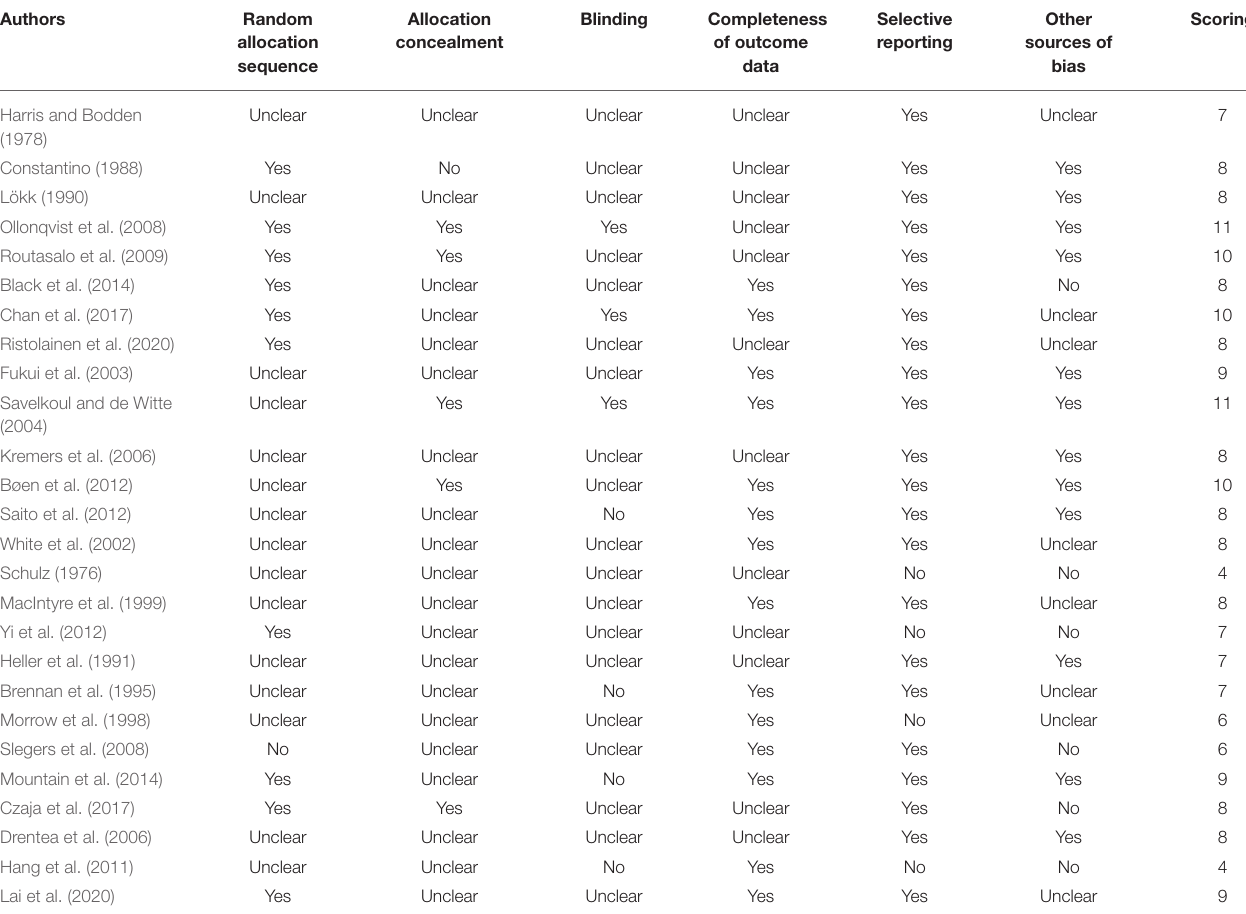
TABLE 2 | Quality of RCT studies included in the systematic